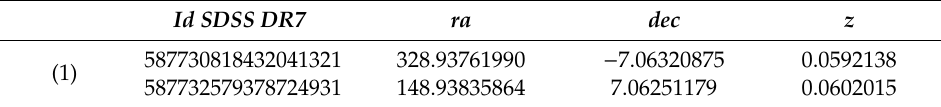
Table 2. The pair with the best positional and redshift accuracy for the e ff ect of cosmic mirror in catalog for ra and dec and 0.001 for z